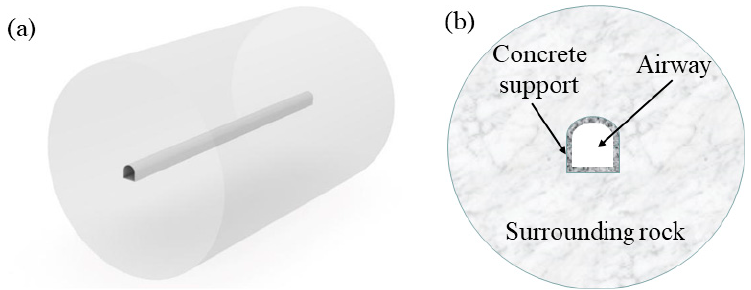
Figure 13. Three-dimensional geometric model: ( a ) stereo view; ( b ) cross-section.